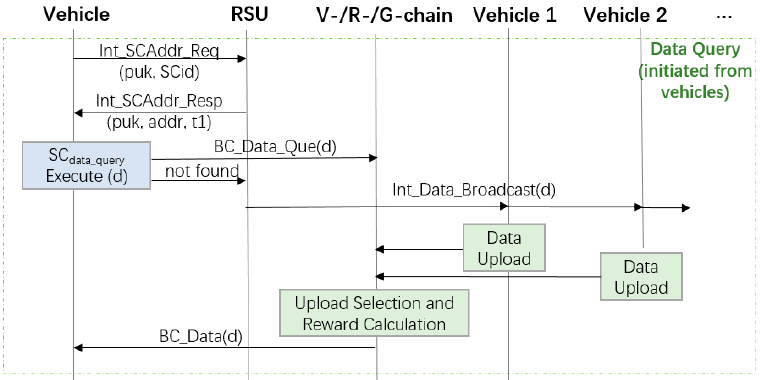
Figure 4. Data query initiated by a vehicle.